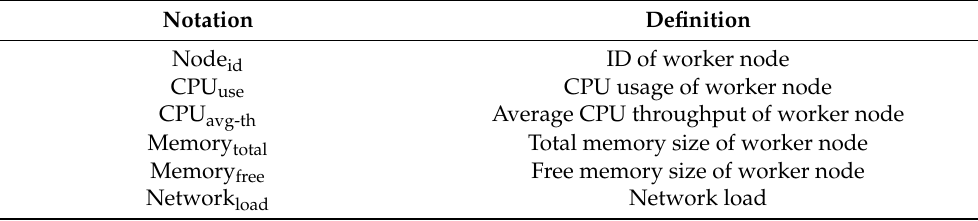
Table 1. Load table